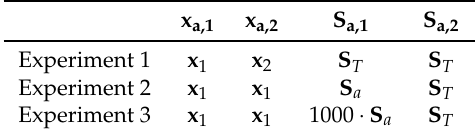
Table 3. Table of retrieval priors for the three